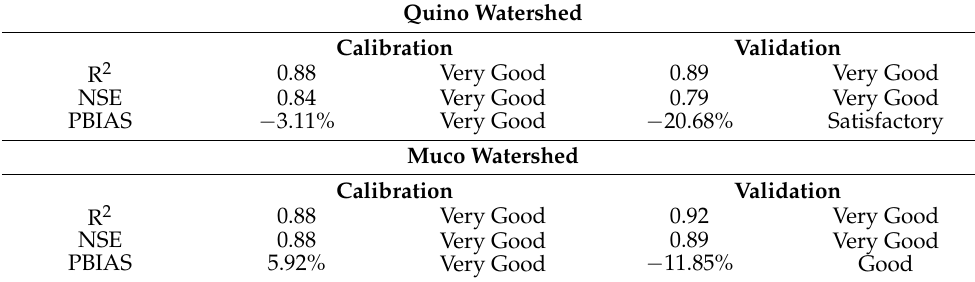
Table A1. Calibration and validation of total monthly flow values and their classification.